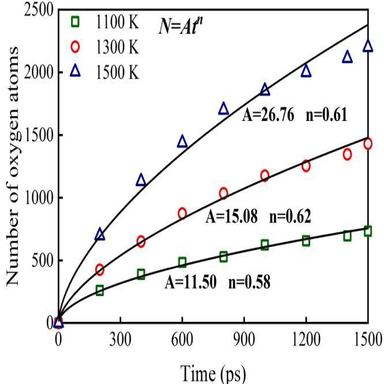
The number of O in the Fe-9Cr steel during the corrosion process at 1100, 1300 and 1500 K. And the surface area of the sample is 5214.5 Å2 .